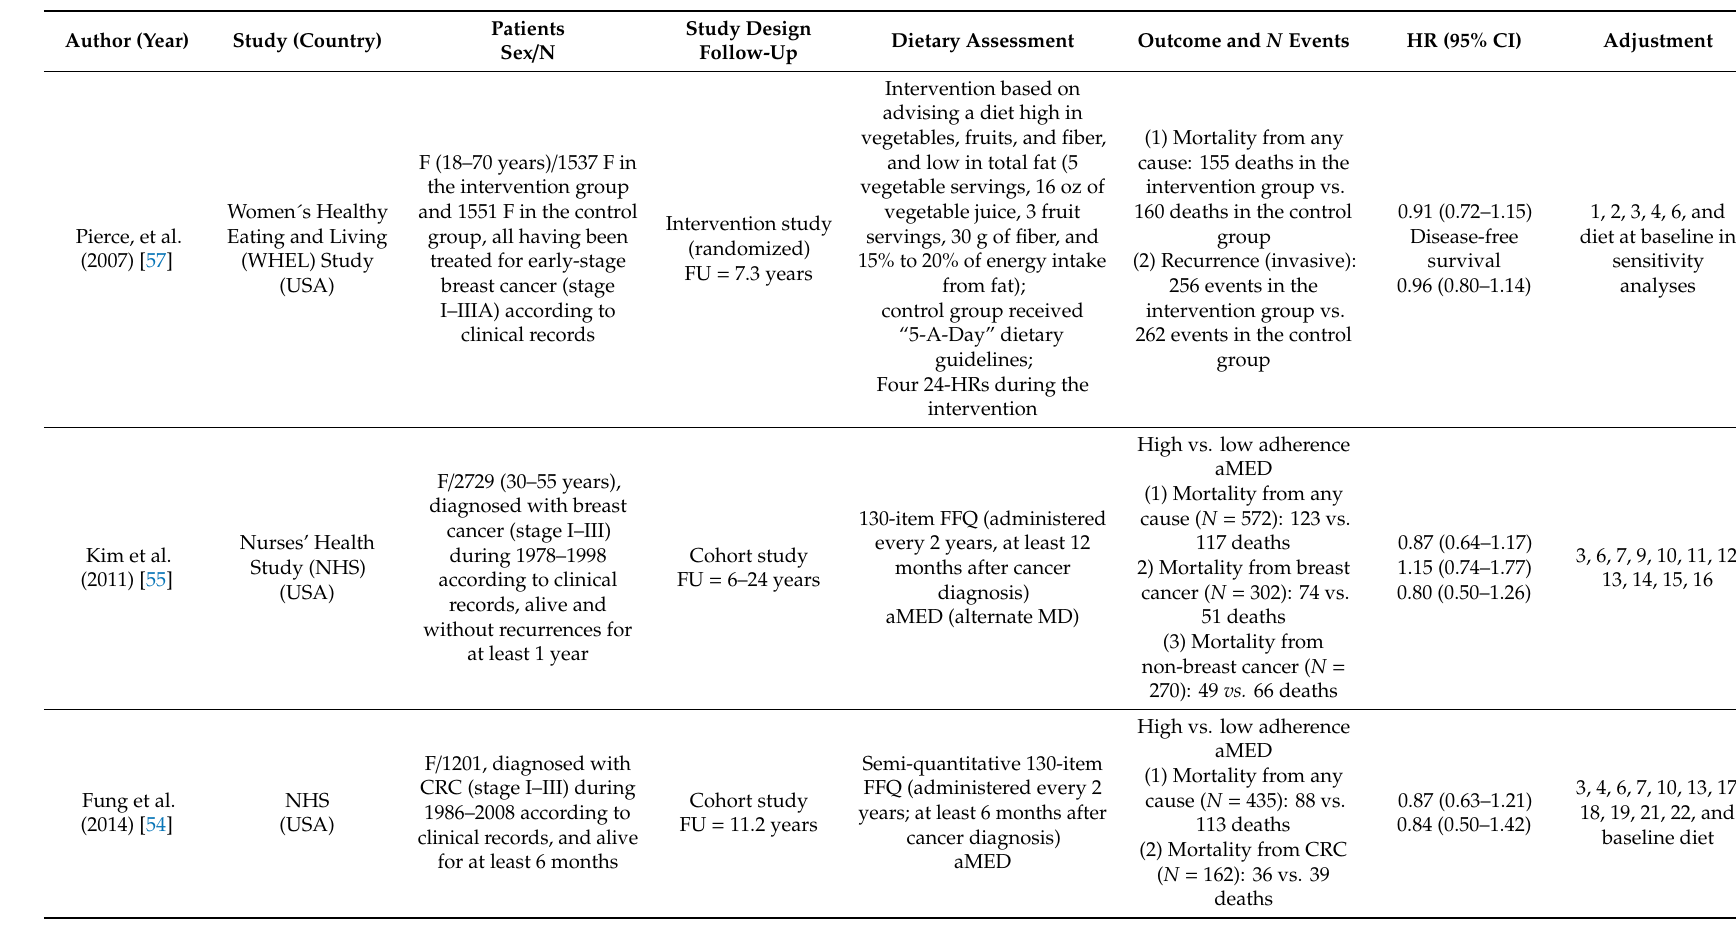
Table 4. Characteristics of the studies evaluating plant-based dietary patterns at post-diagnosis and cancer mortality and